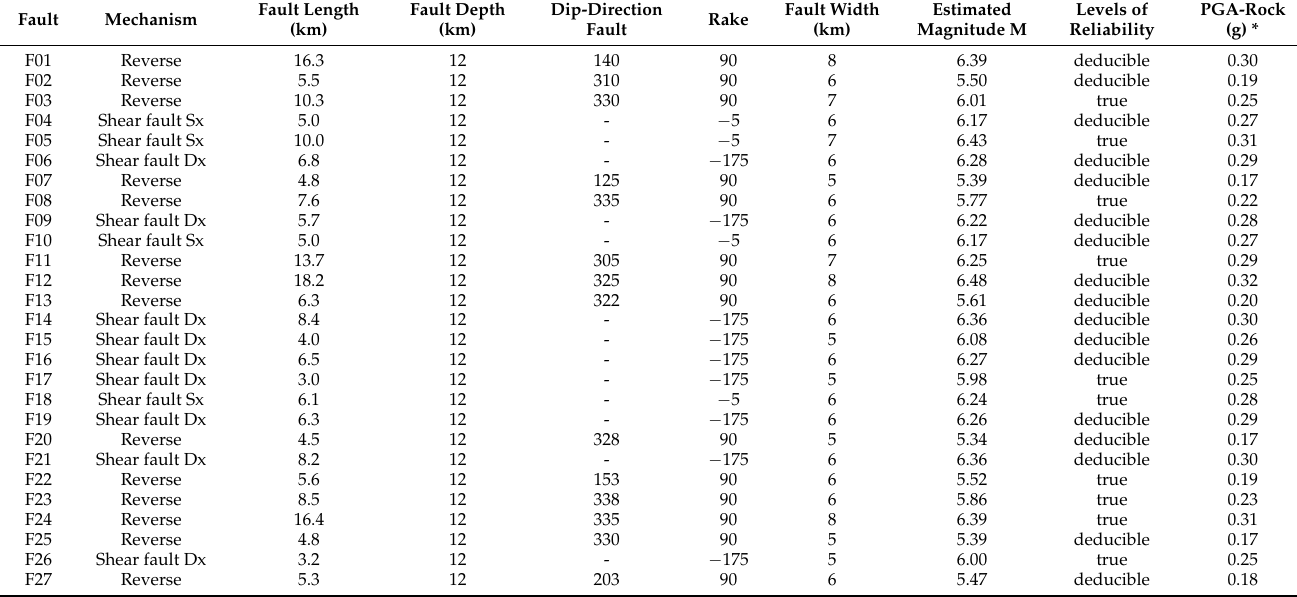
Table 2. List of the present geological faults and their parameters within the canton of Jama based on the Geological Faults Catalog.